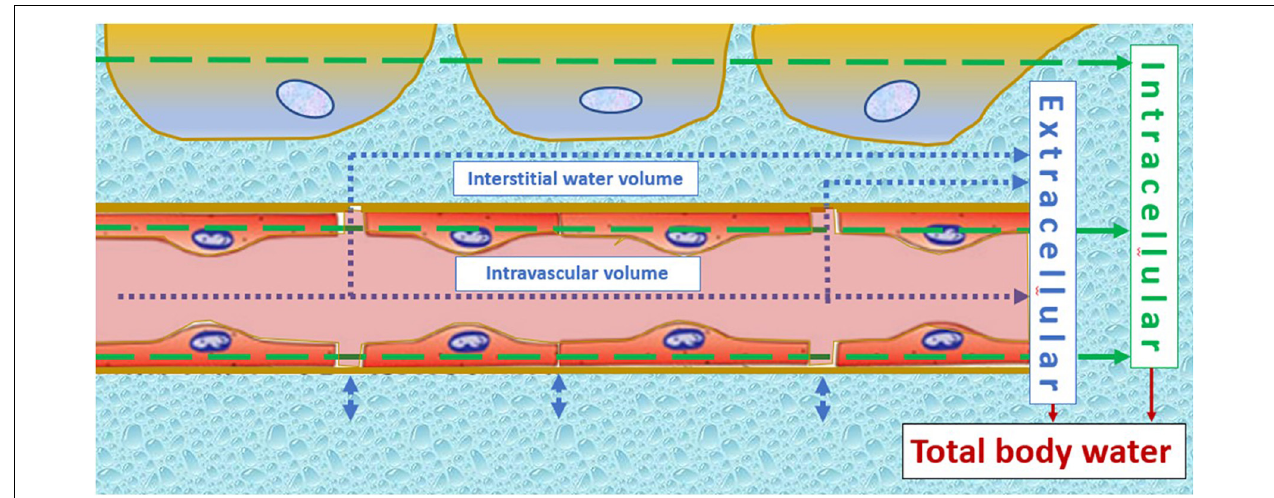
FIGURE 2 | Illustration of the constant fluid exchange between intravascular and interstitial volumes at the level of the microcirculation. This interconnectivity indicates that plasma volume changes cannot be interpreted without knowledge of interstitial water volume, or indirectly via measurement of total body water volume. Normotensive fetal growth restriction relates to a constitutionally low intravascular volume, remaining lower in uncomplicated pregnancies despite normal gestational volume expansion. Early onset preeclampsia, on the other hand, is a state of increased adrenergic activation (155), shifting blood from the venous capacitance bed into the circulation and despite this, cardiac output fails to rise. This can only be explained by a shift from the intravascular compartment to the interstitium, which is in line with clinical signs, such as malleolar or pulmonary edema, in early onset preeclampsia. The arrows indicate the principle of volume estimation by bioimpedance spectrum analysis of intracellular (green) and extracellular (blue) compartments, the latter being the sum of intravascular and interstitial